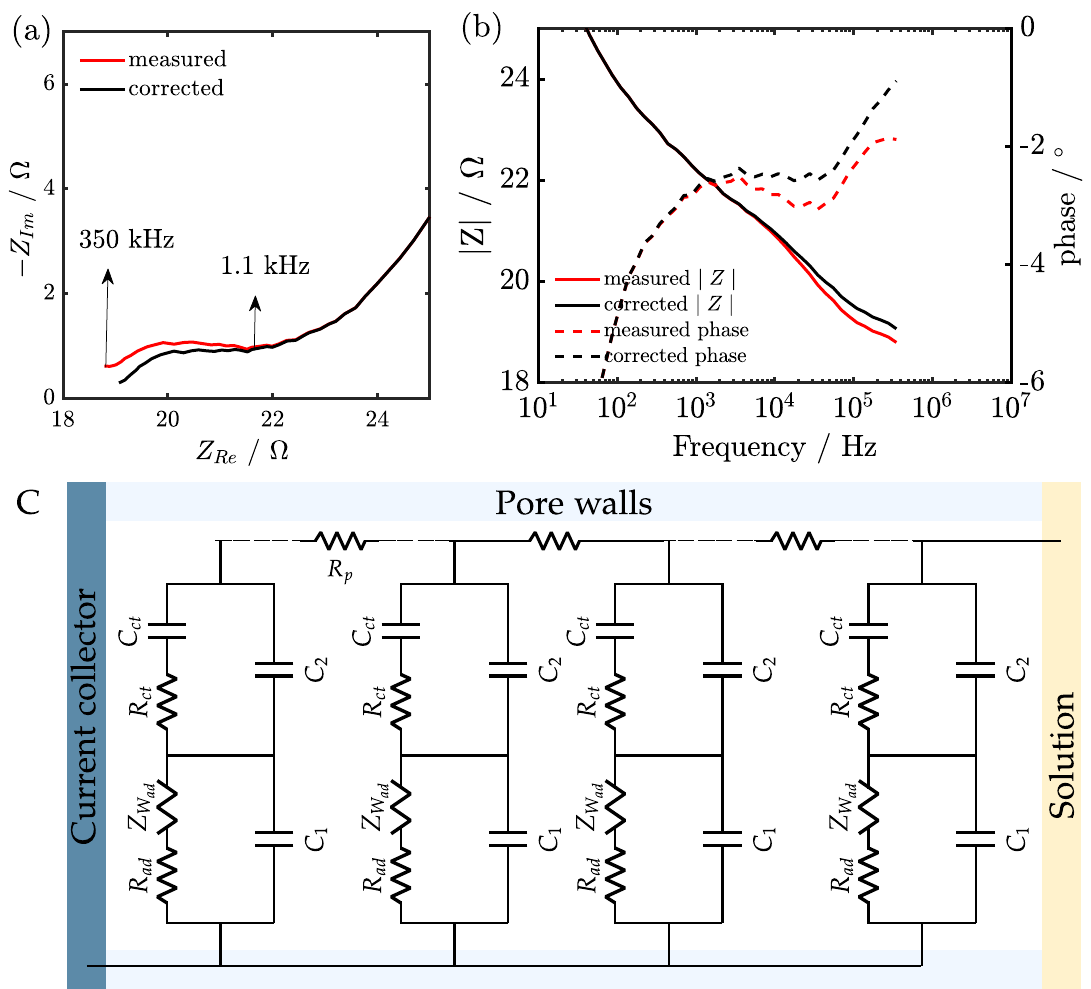
Figure 5. ( a ) and ( b ) Nyquist plot and Bode plot of NiHCF nanoparticles in 0.5 M K 2 SO 4 within the frequency range of 350 kHz to 2.8 Hz at 0.50 V during the cathodic scan respectively. ( c ) Equivalent circuit of the porous electrode including the equivalent circuit obtained from modelling the reversible insertion as two step process treating the capacitance of adsorption ( C ad ) as a short circuit and describing the mass transport in the solid with a capacitor 17